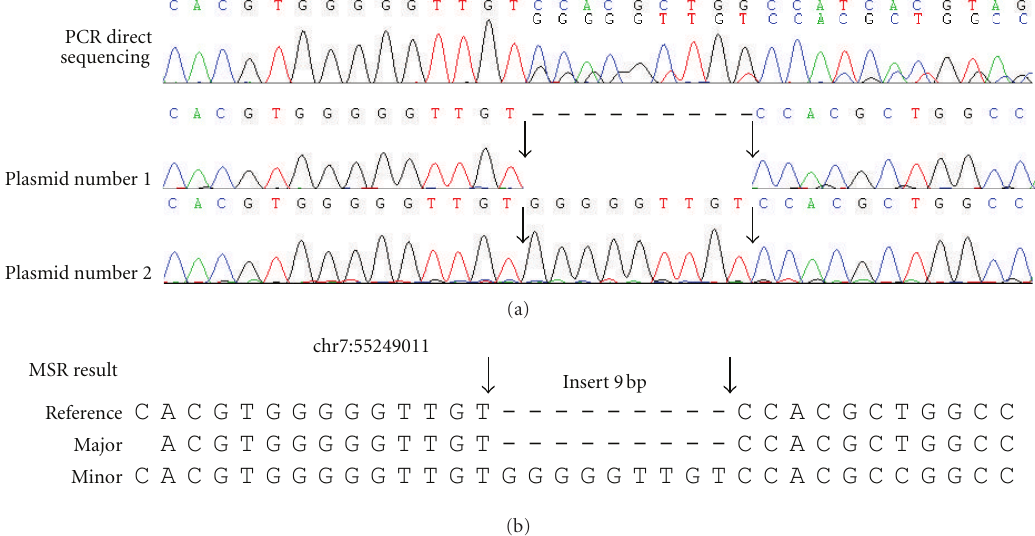
Figure 2: Experimental confirmation of the Indel identified by Mixed Sequence Reader. A 9-bp insertion at chromosome 7:55249011 was detected by Mixed Sequence Reader from a directly sequenced PCR product. (a) PCR direct sequencing chromatography trace, (b) MSR results. The PCR products were cloned, and at least ten single colonies were analyzed by DNA sequencing. One plasmid contained the wild type sequence (plasmid 1); whereas the other plasmids contained an insertion of “GGGGGTTGT,” as shown in plasmid 2 (a). The insertion sequence is shown between two